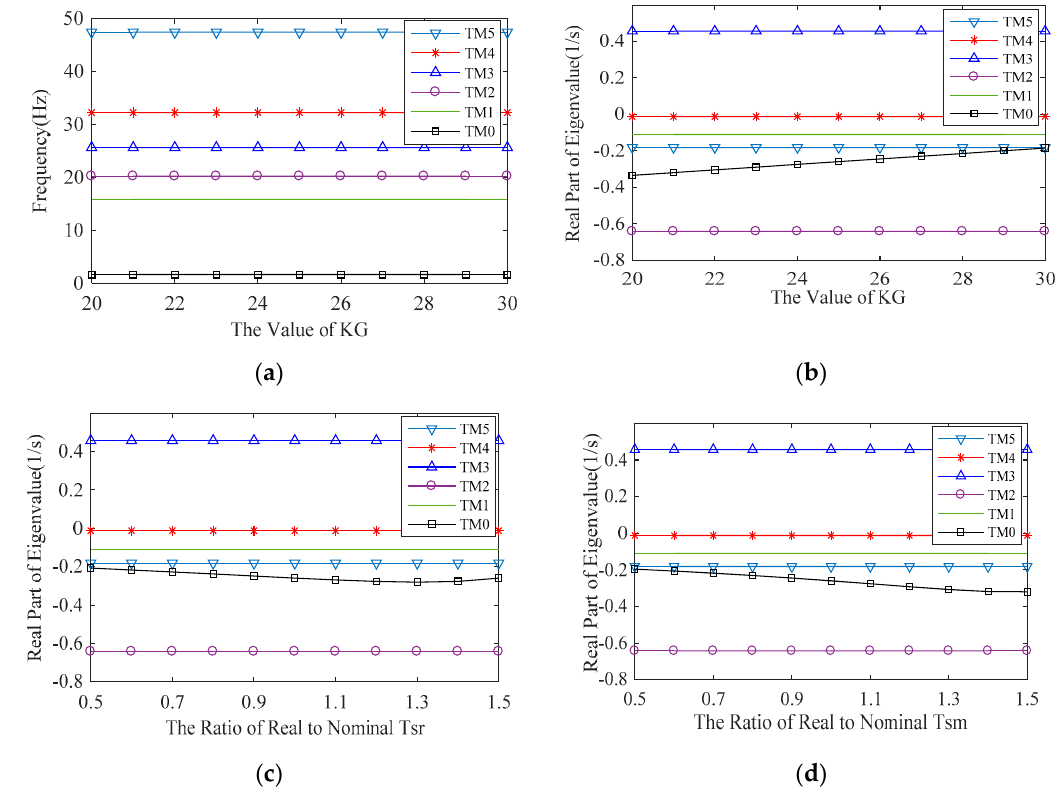
Figure 6. Influence of speed governing system parameters on SSR characteristics. The imaginary parts of eigenvalues a ff ected by ( a ) K G , the real parts of eigenvalues a ff ected by ( b ) K G , ( c ) T SR , ( d ) T SM . K G , T SR and T SM have a large influence on TM0. With the increase of K G and the decrease of T SR and T SM , the real part of TM0 eigenvalue increases significantly, that is, TM0 damping decreases more, which means that the risk of low frequency oscillations in the system is